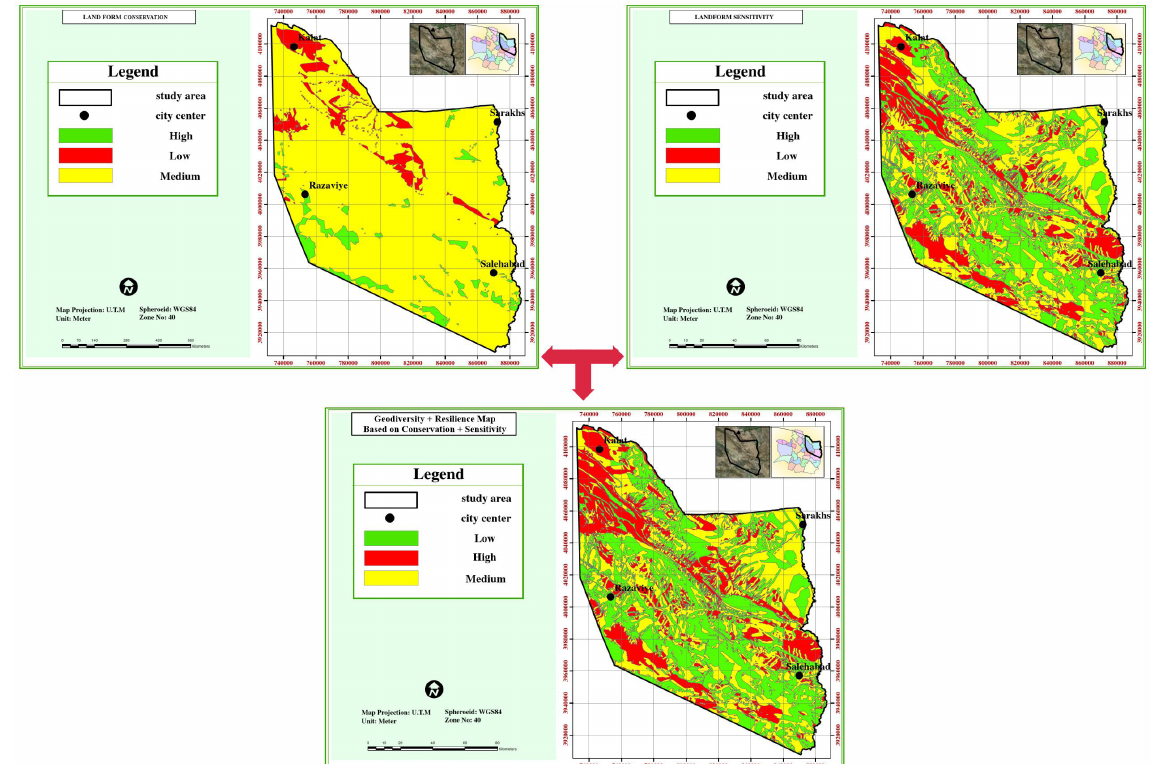
Figure 7. Integration of conservation and sensitivity criteria map and preparation of geodiversity